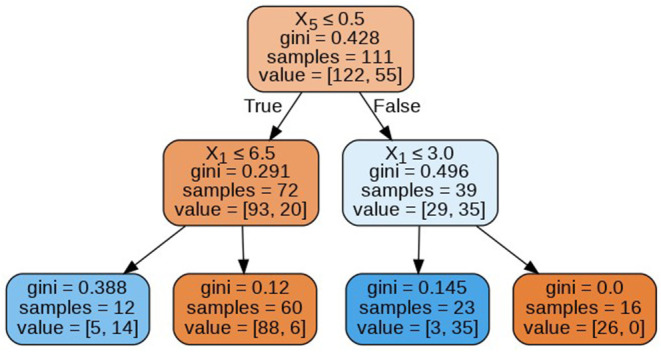
Decision tree 25.